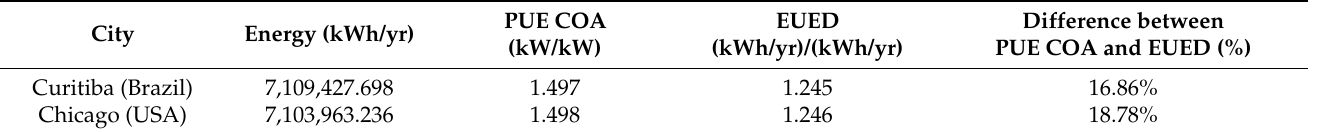
Table 8. Final results using EUED indicator rules.